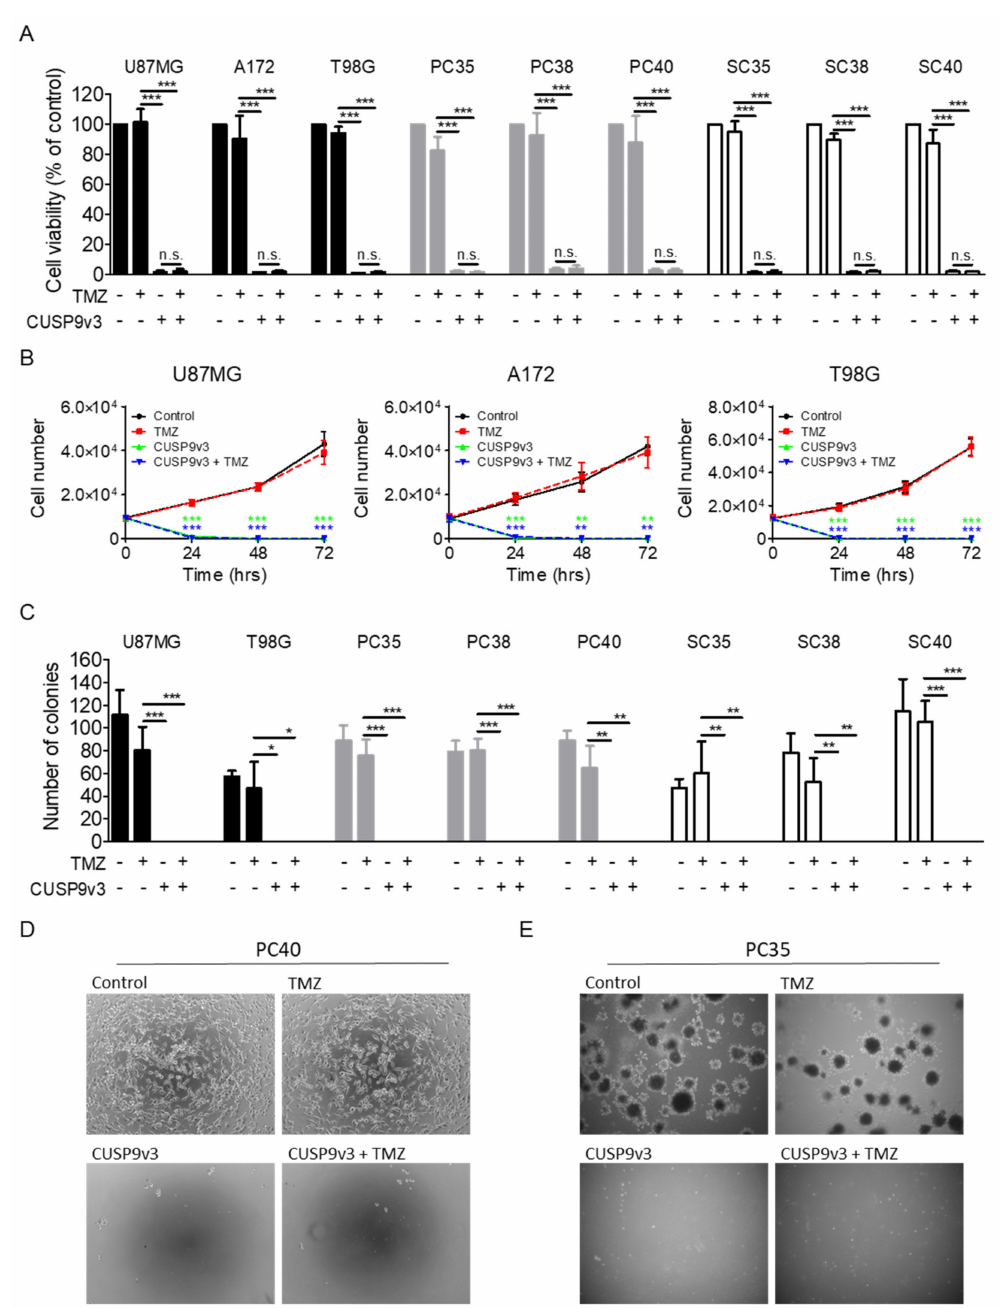
Figure 1. ( A – C ), Data represent three independent experiments and are presented as mean and standard deviation. * p < 0.05, ** p < 0.01, *** p < 0.005 versus TMZ. ( A ), U87MG, A172, T98G established glioblastoma cell lines, PC35, PC38 and PC40 glioblastoma primary cultures and SC35, SC38 and SC40 glioblastoma stem-like cells were treated with solvent, temozolomide (TMZ), CUSP9v3 or CUSP9v3 plus TMZ for 144 h. Cellular viability was determined by MTT assays. ( B ), U87MG, A172 and T98G cells were treated for 72 h as indicated. Cell numbers were determined at indicated time points. ( C ), The indicated glioblastoma cells were seeded in soft agar and treated either with solvent, TMZ, CUSP9v3 or CUSP9v3 plus TMZ for 21 d. Inhibitory effects on anchorage-independent growth were assessed by counting colonies that formed in soft agar. ( D ), Representative microphotographs of PC40 glioblastoma cells treated for 144 h as indicated. Magnification 10 × . ( E ), Representative microphotographs of PC35 colonies in soft agar treated for 21 d as indicated. Magnification 4 ×